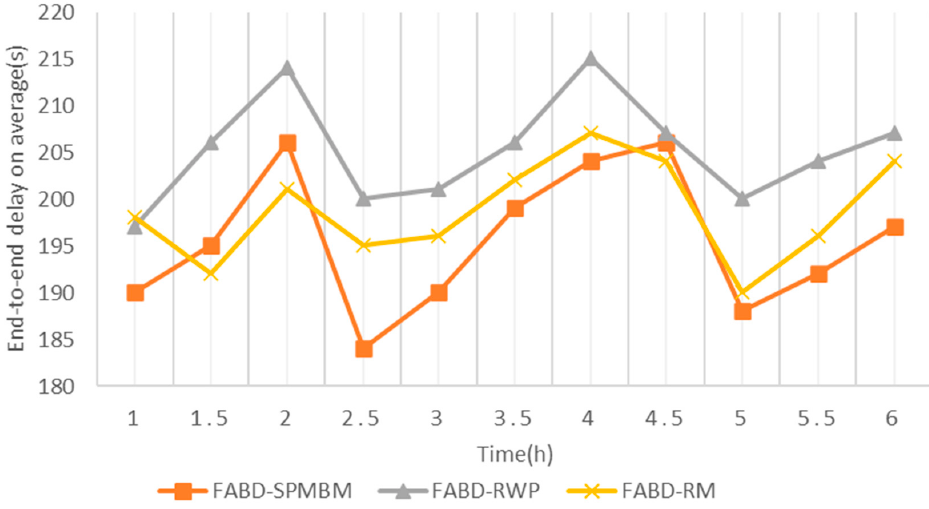
Figure 15. the average delay of the FABD algorithm under the three mobile models. Figure 15. The average delay of the FABD algorithm under the three mobile